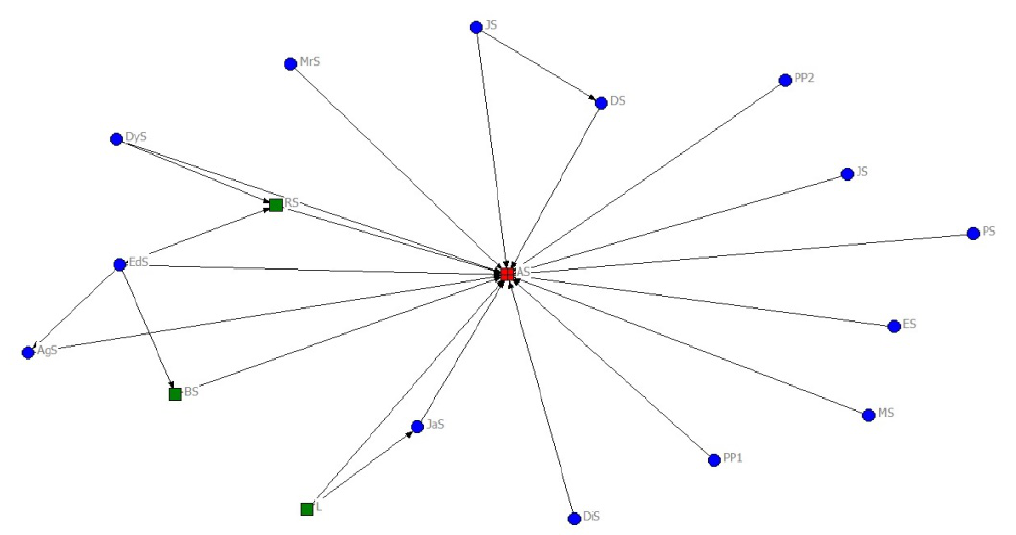
Figure 1: Mapping of AS Group Social Networks